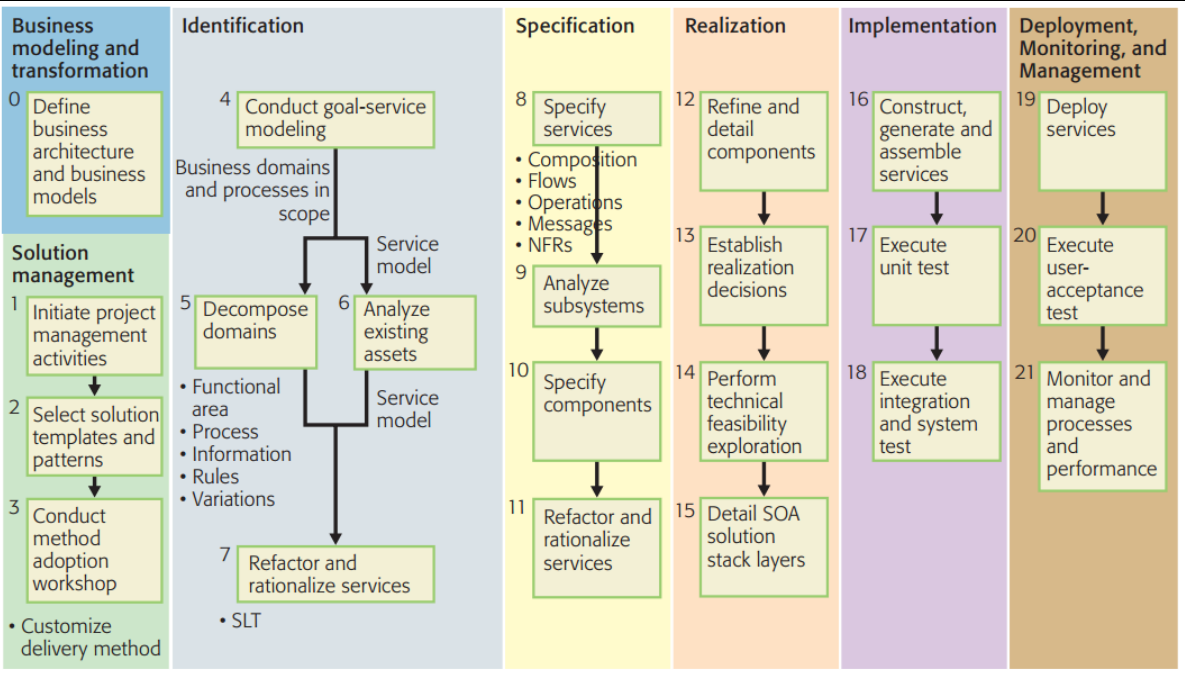
Figure 2. SOMA life Cycle